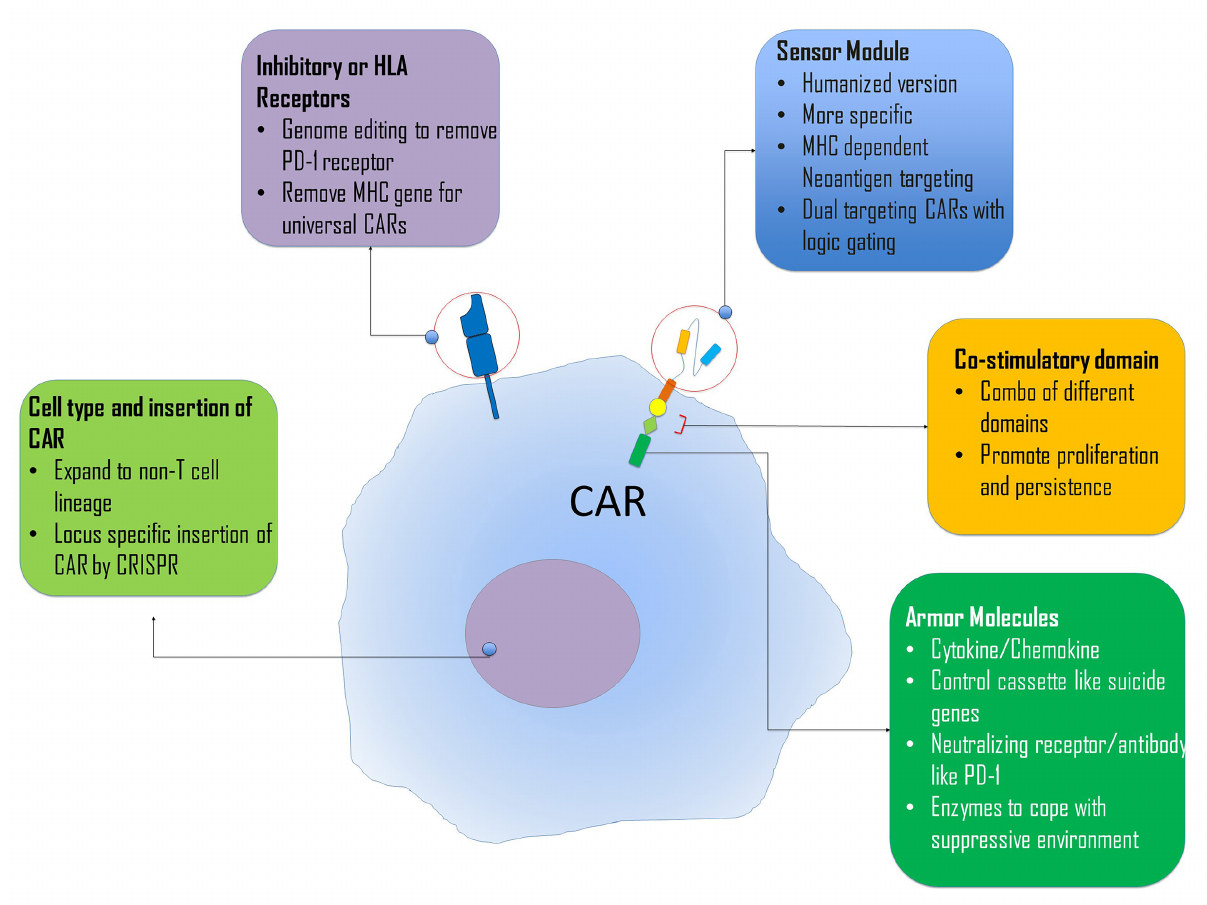
Figure 3. The summary of CAR design listing the current focus of various CAR